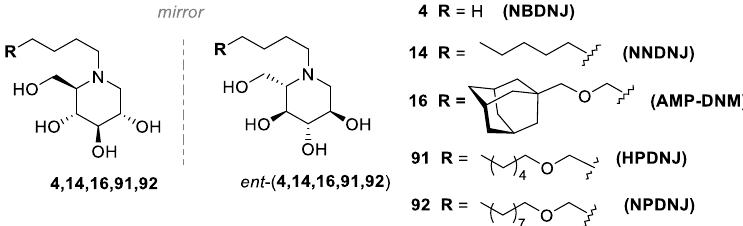
Figure 22. N -Alkylated D - and L -DNJ derivatives. This figure is reprinted from [179], with permission from Elsevier.